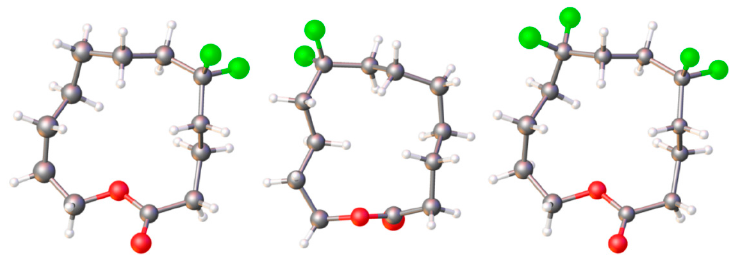
Figure 3. Fluorinated 12-dodecanolides.